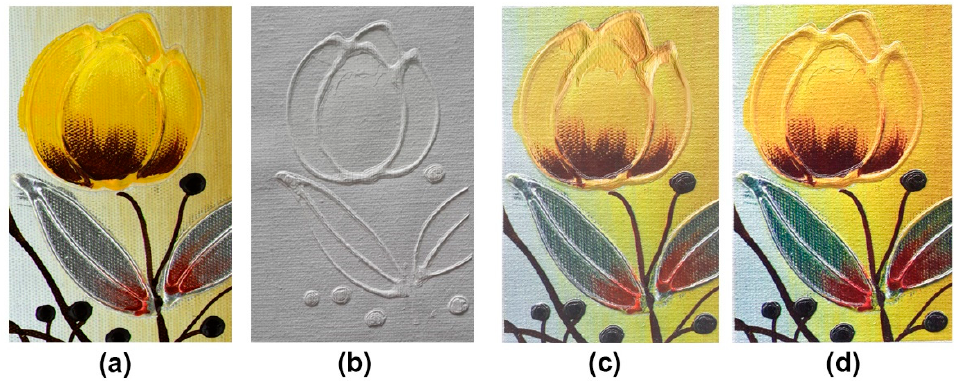
Figure 5. The visualization difference between digital original source and 3D-printed replicas: ( a ) photogrammetry-based 3D model; ( b ) blank 3D model; ( c ) regular color 3D model; and ( d ) revised color 3D model.